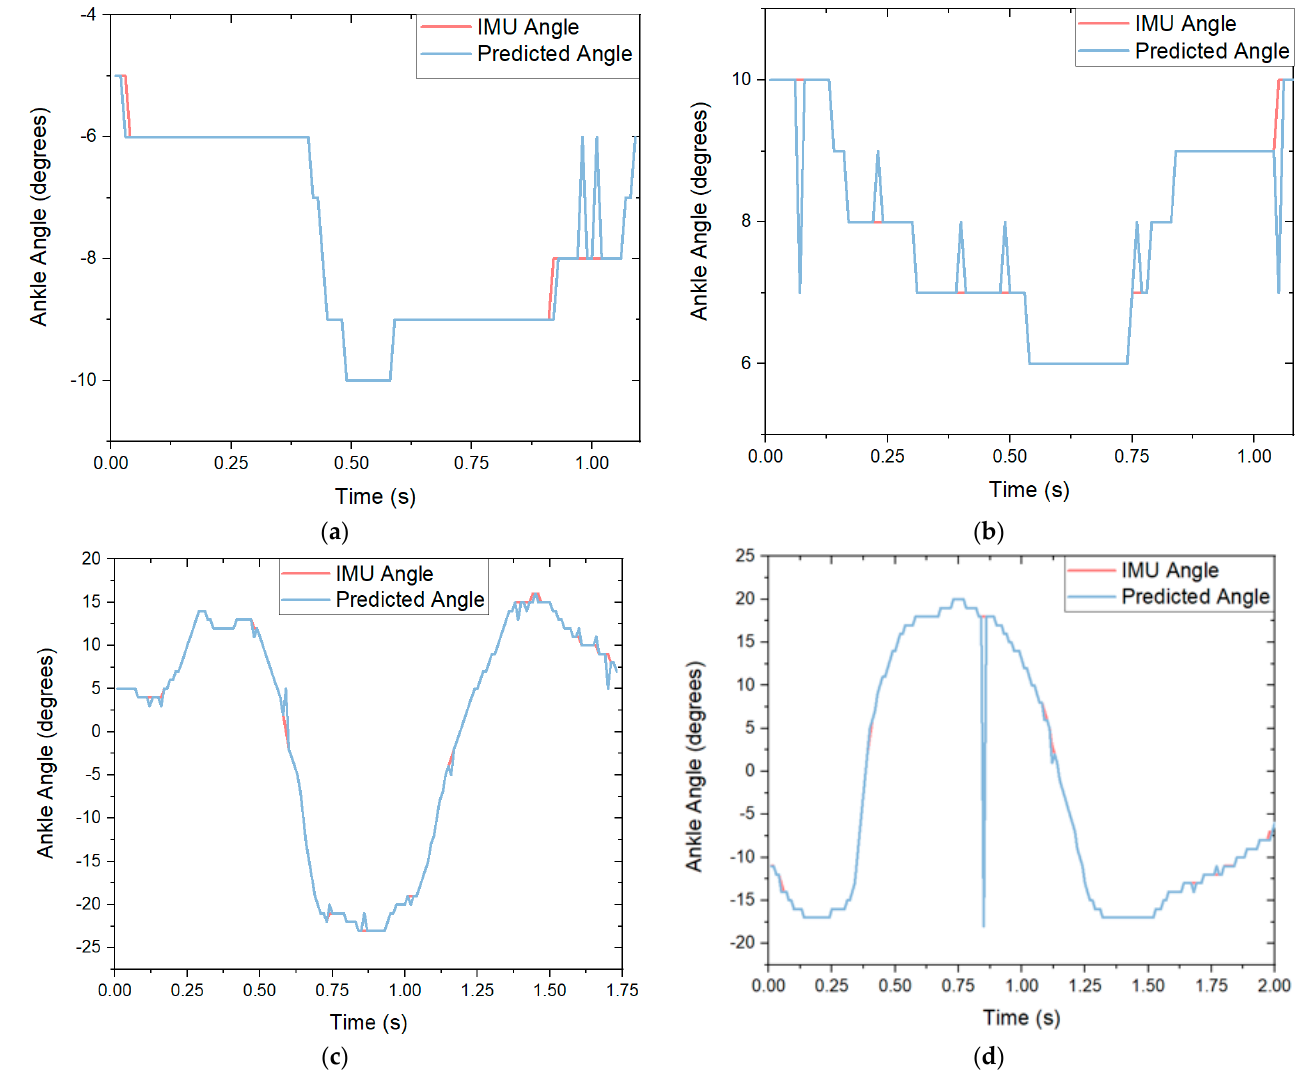
Figure 8. The Xsens-predicted angle compared with the algorithm-predicted ankle angle in the y -axis for each movement: ( a ) graph of a single squat movement on the left foot with an accuracy of 94.2%; ( b ) graph of a single squat movement on the right foot with an accuracy of 92.4%; ( c ) graph of a single right stoop movement on the left foot with an accuracy of 90.2%. ( d ) graph of a single left stoop movement on the right foot with an accuracy of 88.9%.